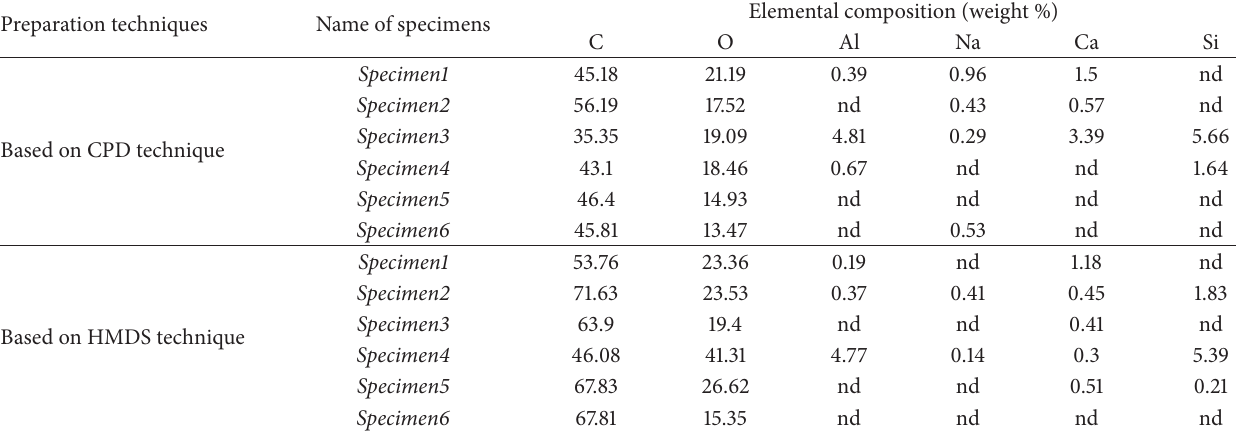
Table 1: Elemental composition of mapping EDX of six cervical samples based on CPD and HMDS techniques.